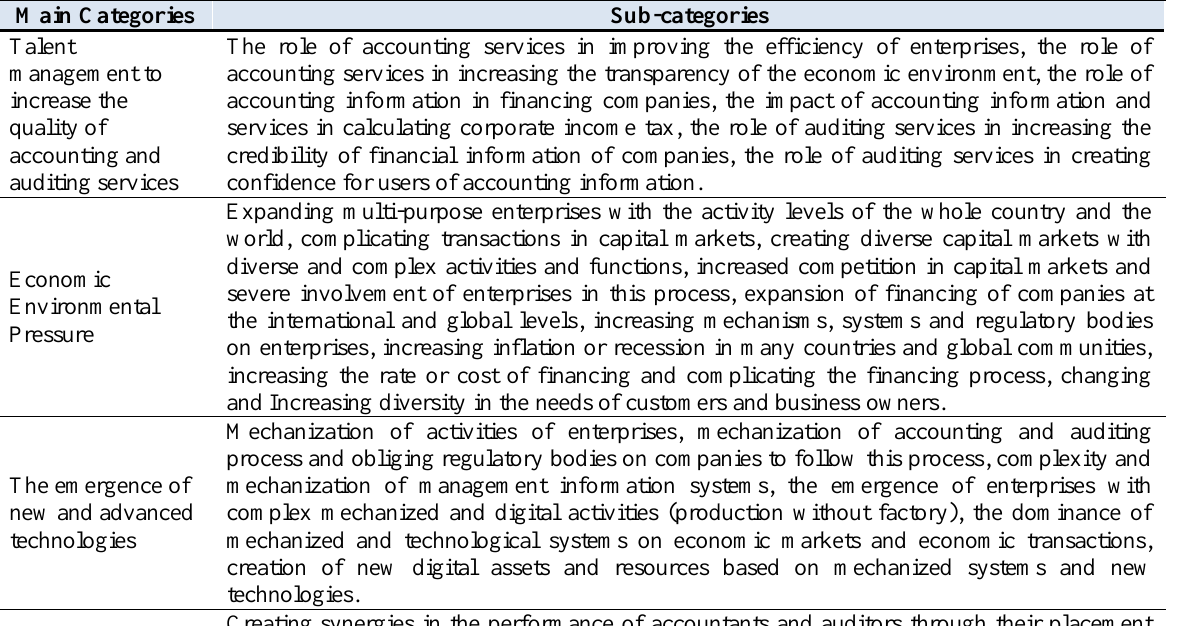
Table 2: Some of the concepts and categories extracted from the open coding